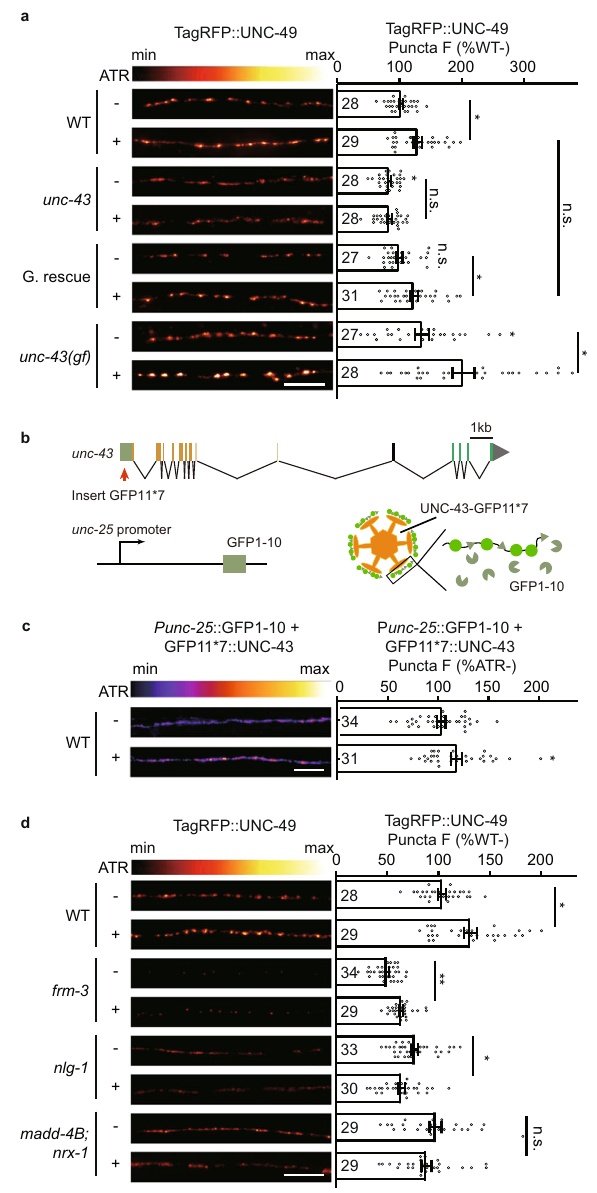
Fig. 9 | UNC-43/CaMKII is required for activity-dependent plasticity at GABAergic synapses. a Presynaptic UNC-43 is required for activity-dependent GABAergic plasticity. TagRFP-UNC-49 puncta fl uorescence intensity was increased afterGABAergicmotorneuronexcitationbyChIEFactivationinwildtypeandinthe unc-43 gain-of-functionmutants,butnotinthe unc-43 lossoffunctionmutants,and thiswasrescuedby transgenic expression of UNC-43 in GABAergic motor neurons (G. rescue). Representative images (left, scale bar 10 μ m, Pseudo-color: Red Hot) and mean puncta intensities+/ − SEM (right, Ns represent the number of animals tested) are shown. Kruskal – Wallis test with two-stage linear step-up procedure of Benjamini, Krieger, and Yekutieli correction for multiple comparisons. * p <0.05, n.s. not signi fi cant. b Schematic illustration of split GFP experimental design to label endogenous UNC-43 at GABAergic motor neurons. Seven copies of the split GFP11wereinsertedintotheN-terminalof unc-43 genomiclocibytheCRISPR-Cas9 system. The split GFP1-10 was expressed in GABAergic motor neurons by unc-25 promoters. c The GABAergic presynaptic localization of UNC-43 was increased after GABAergic motor neuron excitation by ChIEF activation. split GFP labels endogenous UNC-43 in GABAergic neurons. Representative images (left, scale bar 10 μ m,Pseudo-color:Fire)andmeanpunctaintensities+/ − SEM(right,Nsrepresent thenumberofanimalstested)areshown.Two-tailedMann – Whitneytest.* p <0.05. d MADD-4B,NRX-1 α ,andNLG-1,butnotFRM-3,arerequiredforactivity-dependent plasticity at GABAergic synapses. Representative images (left, scale bar 10 μ m, Pseudo-color: Red Hot) and mean puncta intensities+/ − SEM (right, Ns represent the number of animals tested) are shown. The data for WT is the same as in a . Kruskal – Wallis test with two-stage linear step-up procedure of Benjamini,